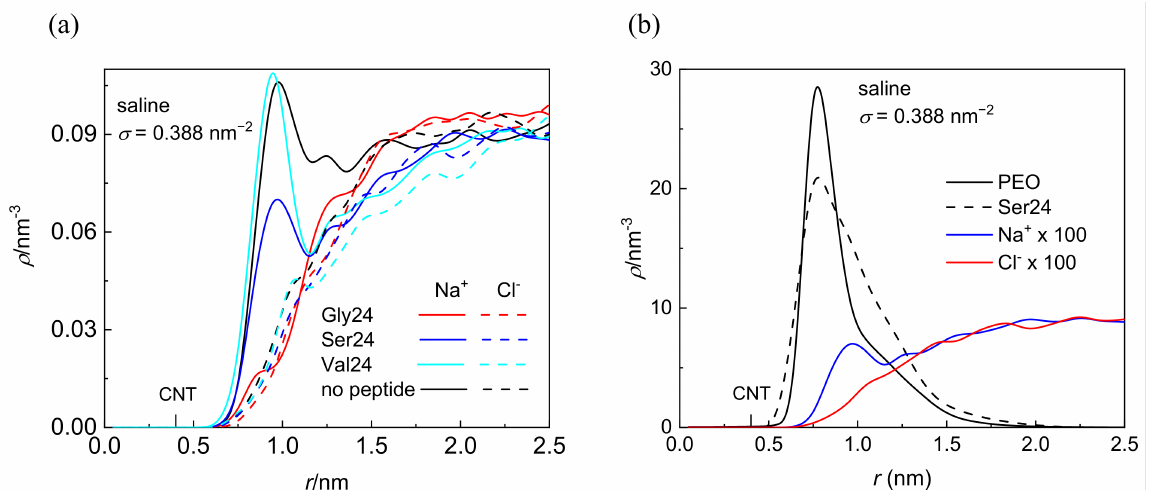
Figure 4. Cylindrical density distribution of sodium cations and chloride anions in systems containing CNT grafted with the PEO chains at σ = 0.388 nm − 2 in the presence or absence of the peptides ( a ) and of heavy atoms of the PEO chains, all atoms of polyserine, sodium cations, and chloride anions in a system composed of polyserine and CNT grafted with the PEO chains at σ = 0.388 nm − 2 ; the values of ions are rescaled by the numerical factor of 100 ( b ). The position of the CNT sidewall is also